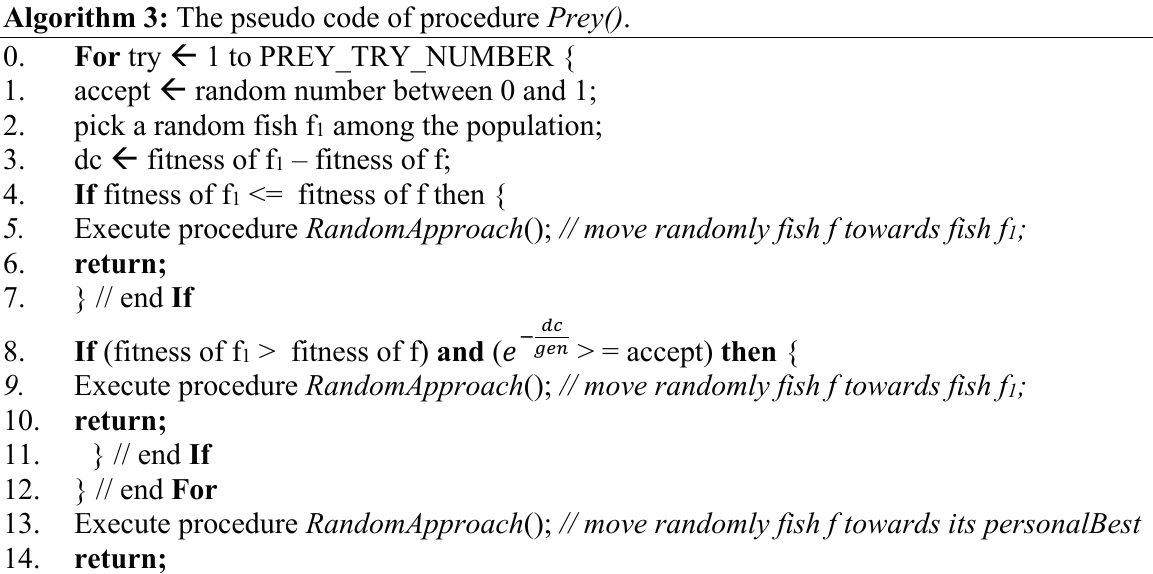
Algorithm 3: The pseudo code of procedure Prey()